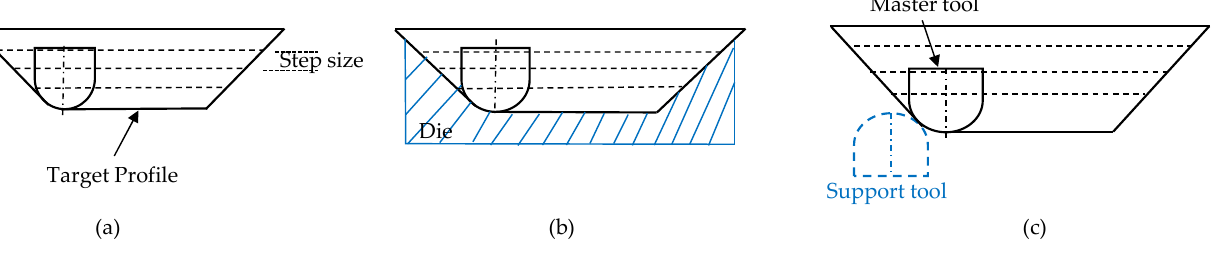
Figure 1. Schematics of ISF Processes ( a ) SPIF ( b ) TPIF ( c ) DSIF.